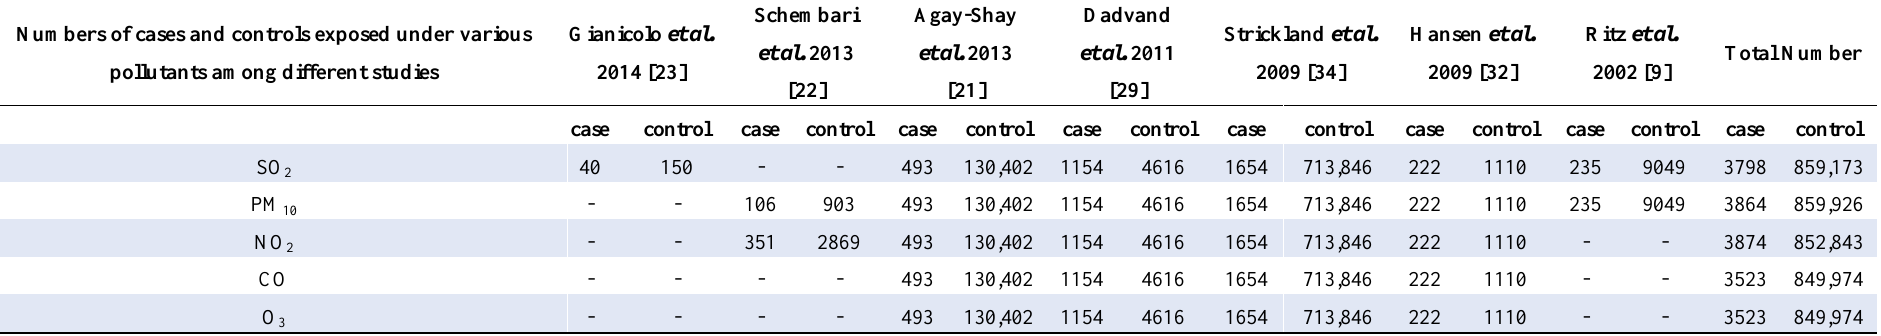
Table 3. Numbers of ventricular septal defects cases and number of controls in studies included in the meta analysis for 5 pollutants: SO , PM , NO , CO, O 2 10 2 3.